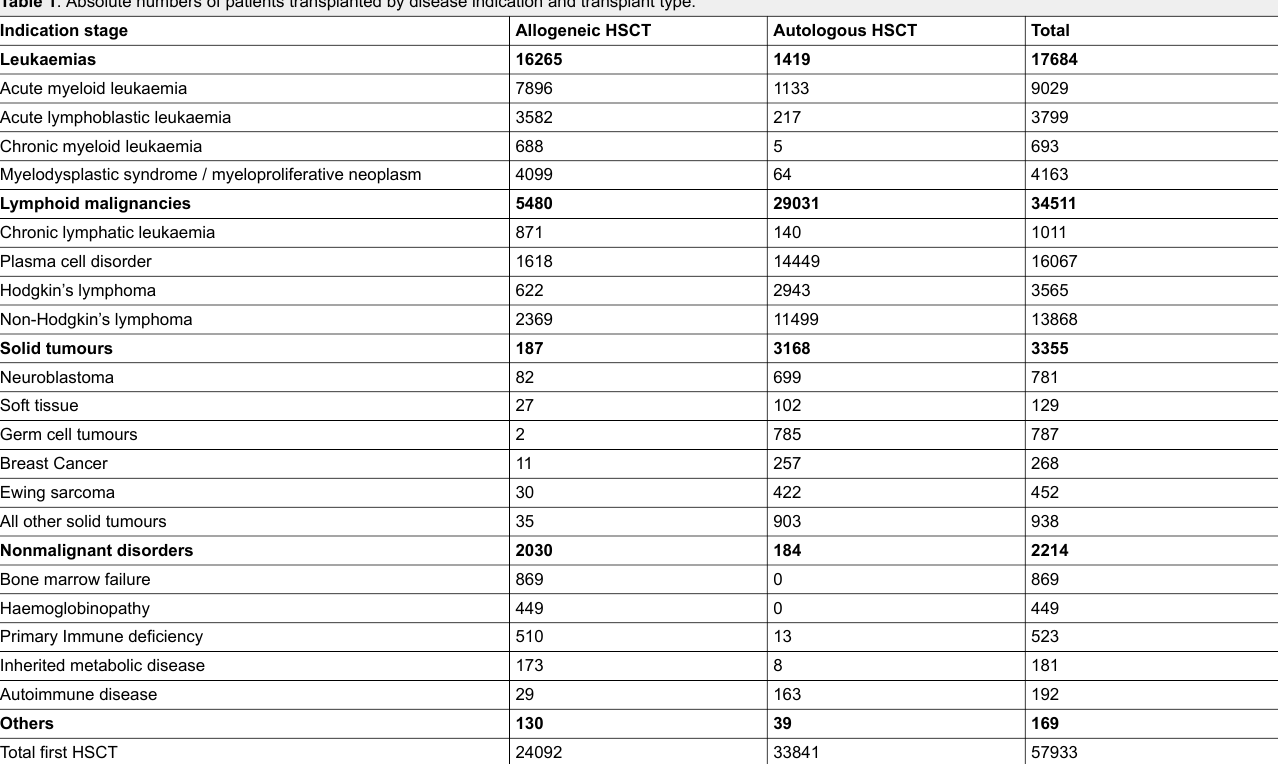
Table 1 : Absolute numbers of patients transplanted by disease indication and transplant type. Indication